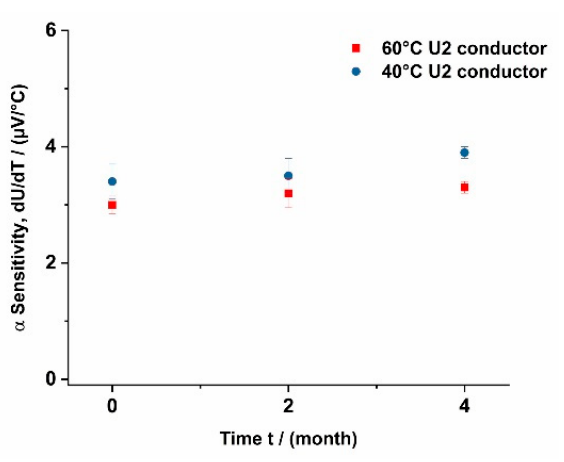
Figure 5. Long-term stability of sensor arrangements using copper-coated lyocell fabrics as substrates.